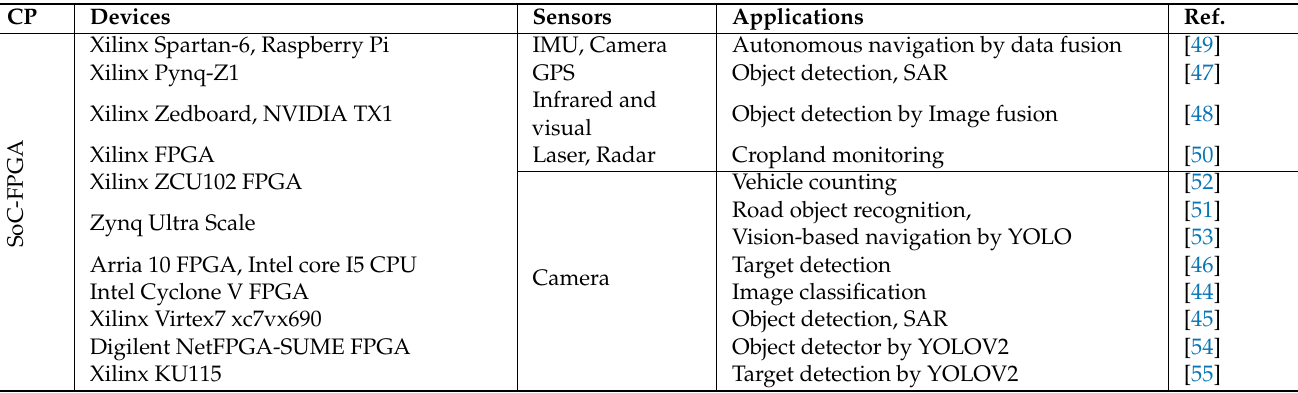
Table 4. The summary of FPGA-based NNAs used in UAVs.